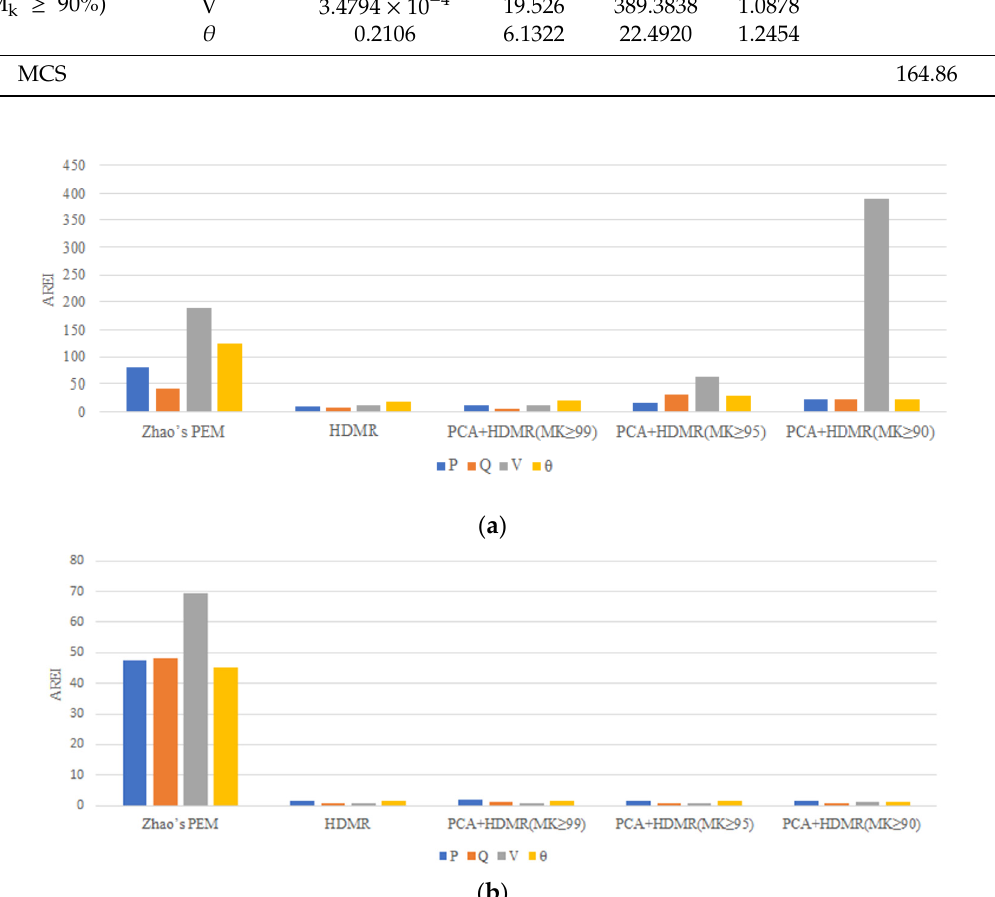
Figure 1. ( a ) 3 ε of evaluated methods and ( b ) 4 ε of evaluated methods. Figure 1. ( a ) ε 3 of evaluated methods and ( b ) ε 4 of evaluated